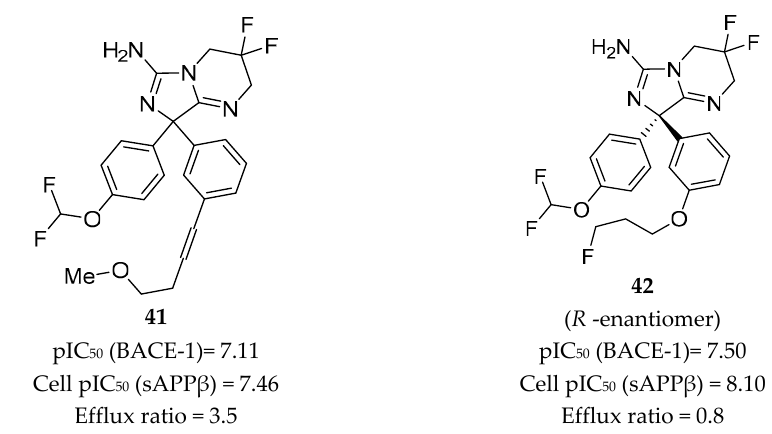
Figure 33. Aminoimidazole-based inhibitors 41 – 42 developed by AstraZeneca.